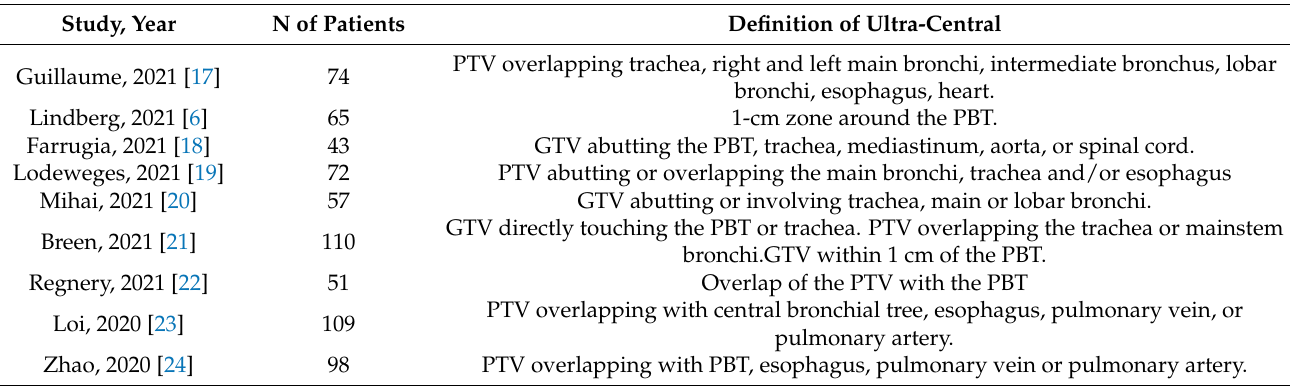
Table 1. Ultra-central